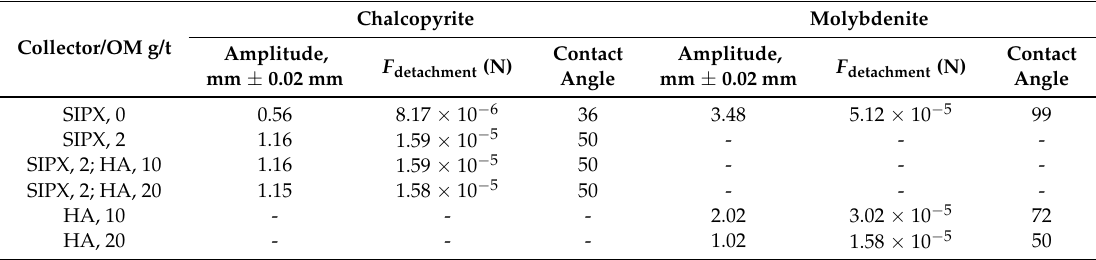
Table 4. Critical amplitude of vibration (50 Hz) for the detachment of chalcopyrite and